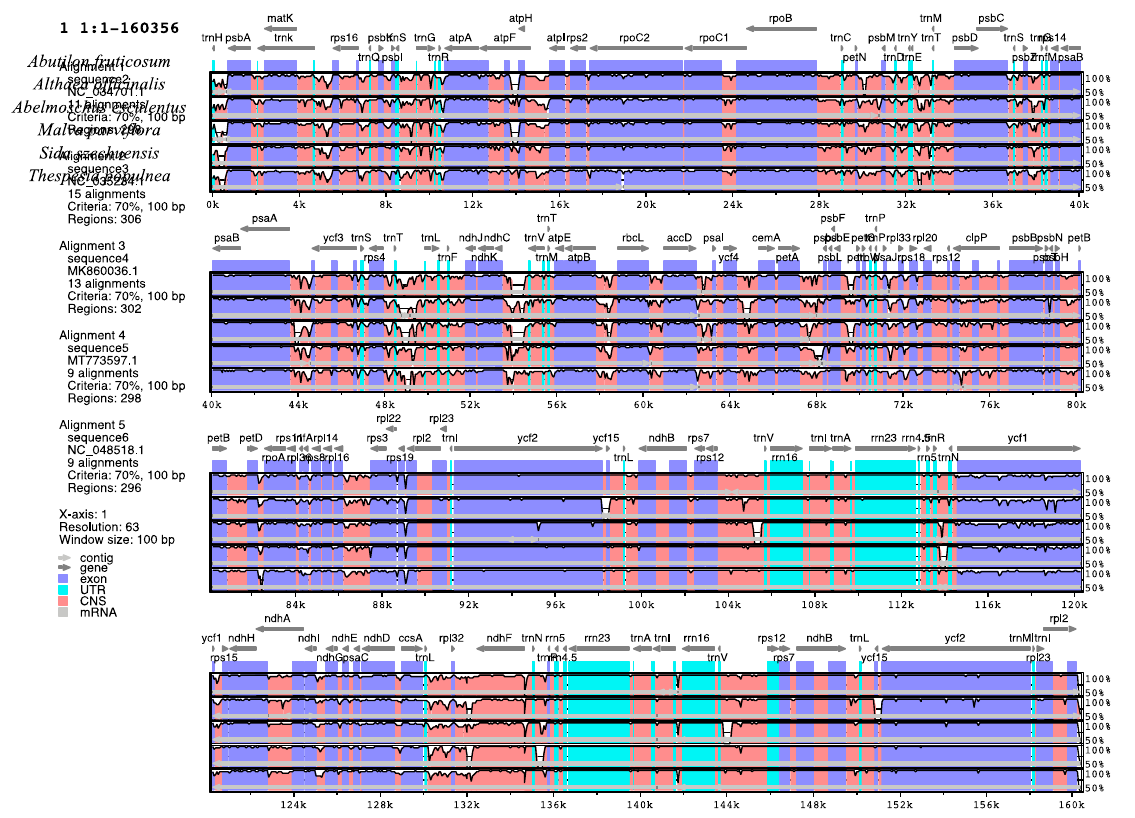
Figure 7. Sequence alignment of six chloroplast genomes of representatives of the Malvaceae family performed with mVISTA using annotation of A. fruticosum as a reference. The top arrow shows transcription direction, blue color indicates protein-coding sequences, pink color shows conserved non-coding sequences (CNS) and light green indicates tRNAs and rRNAs. The x-axis represents the coordinates in the cp genome, while the y-axis represents percentage identity within 50–100%.